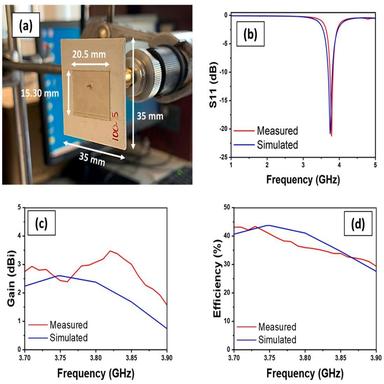
(a) Probe-fed microstrip patch antenna operating at a 3.78 GHz, using a 3D printed BST/ABS composite substrate, measured vs. simulated results (b) reflection coefficient, (c) gain and (d) total efficiency.